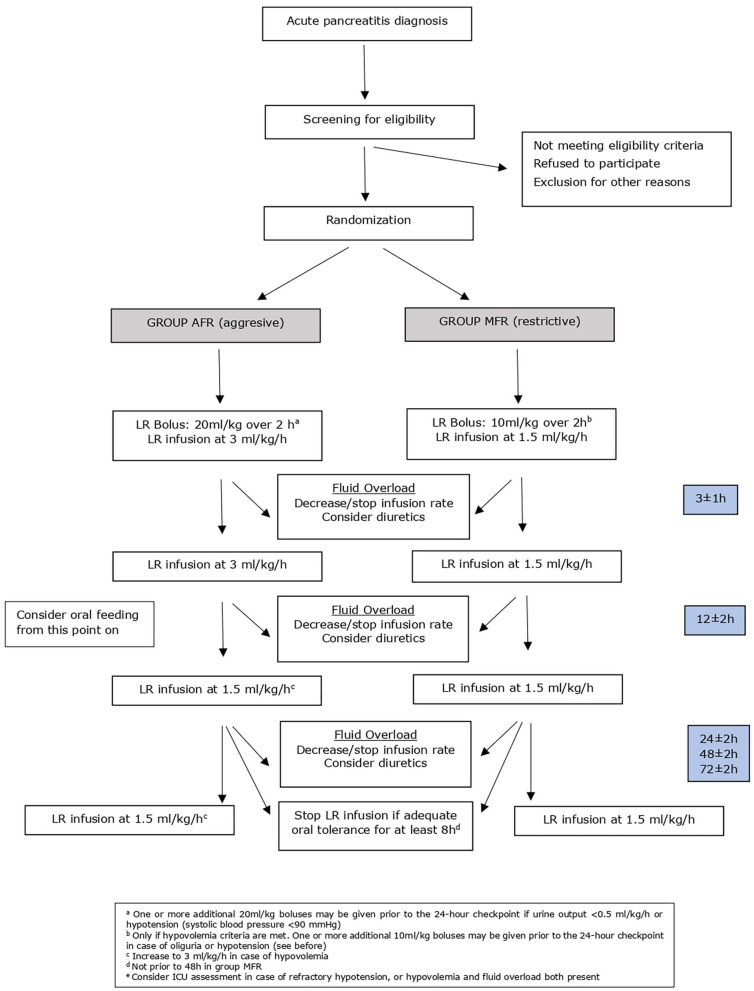
Detailed treatment protocol.